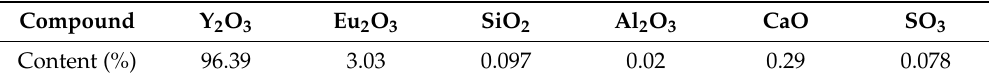
Figure 11. SEM image of the RE precursor. 3.4. High Temperature Solid-State Currently, solid phase method is commonly used in the industry to synthesize Y 2 O 3 :Eu because of its simple operation. Phosphors synthesized with the solid phase method (reaction, process, synthesis) have high brightness and stable performance, and can be easily extended in the industry. Thus, in this study, the solid phase method was used to synthesize Y 2 O 3 :Eu. This nano crystalline precursor was processed further by annealing at 1400 ° C with or without sintering aids to yield